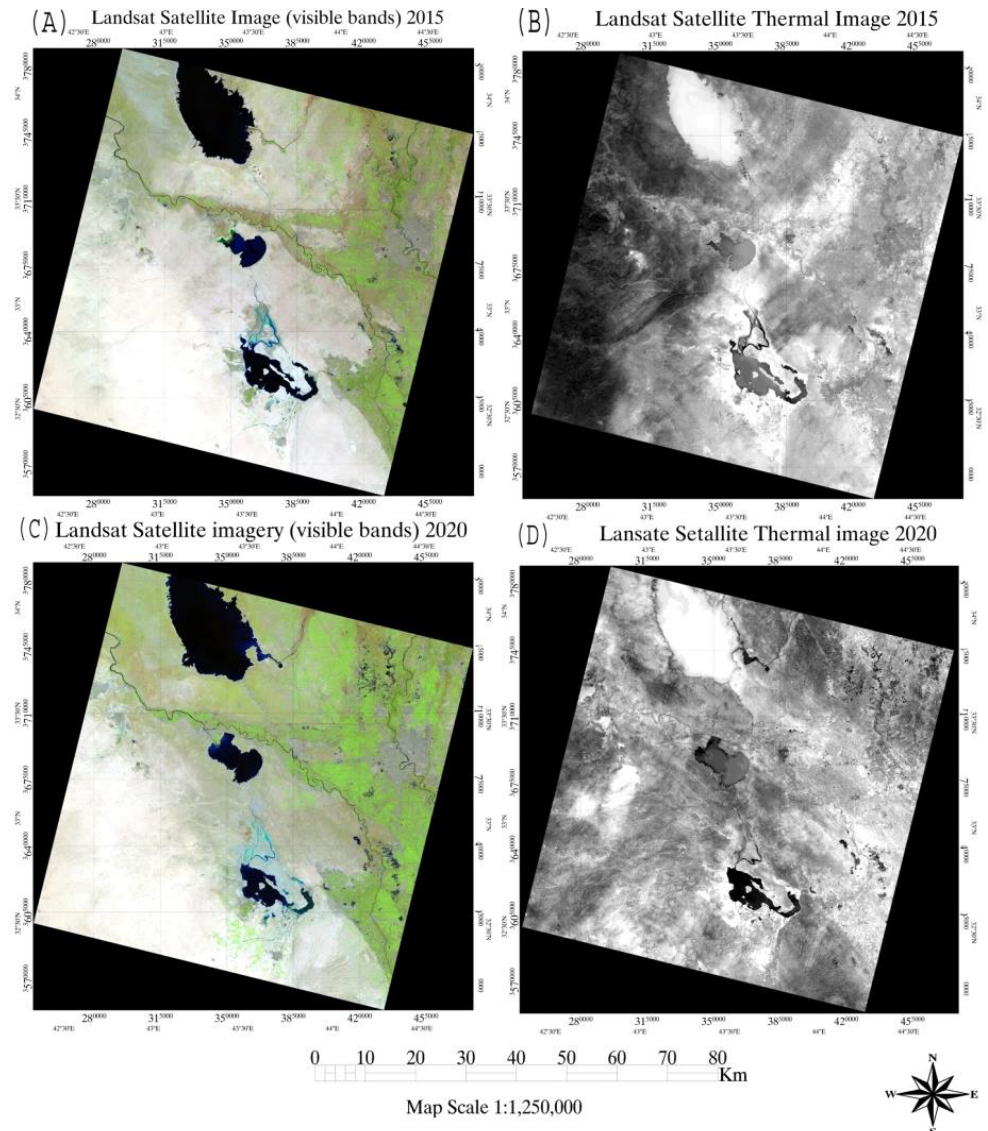
Figure 3. All the corrected satellite images, free of all the noise: (A) the corrected visible Landsat-8 satellite image of the year 2015; (B) the corrected thermal Landsat-8 satellite image of the year 2015; (C) the corrected visible Landsat-8 satellite image of the year 2020; (D) the corrected thermal Landsat satellite image of the year